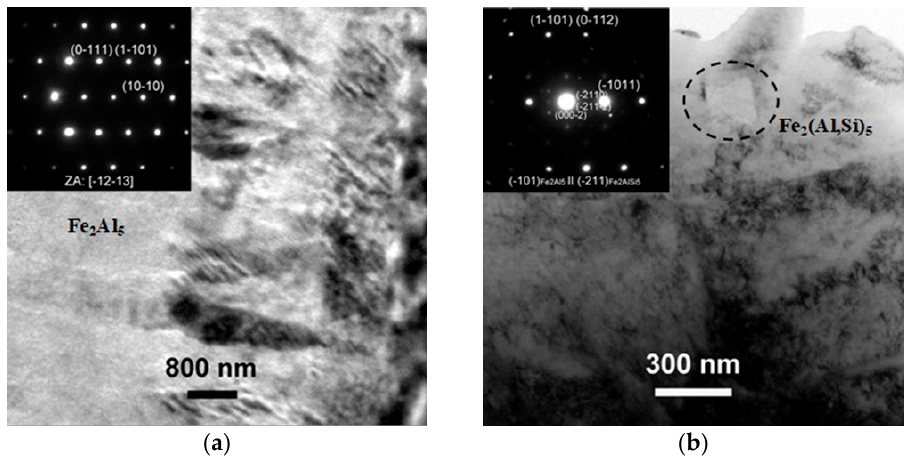
Figure 10. TEM micrographs of ( a ) the coating layer composed of Fe 2 Al 5 and ( b ) detail of the Fe 2 Al 5 layer, showing a cuboid-like Fe 2 (Al,Si) 5 particle.